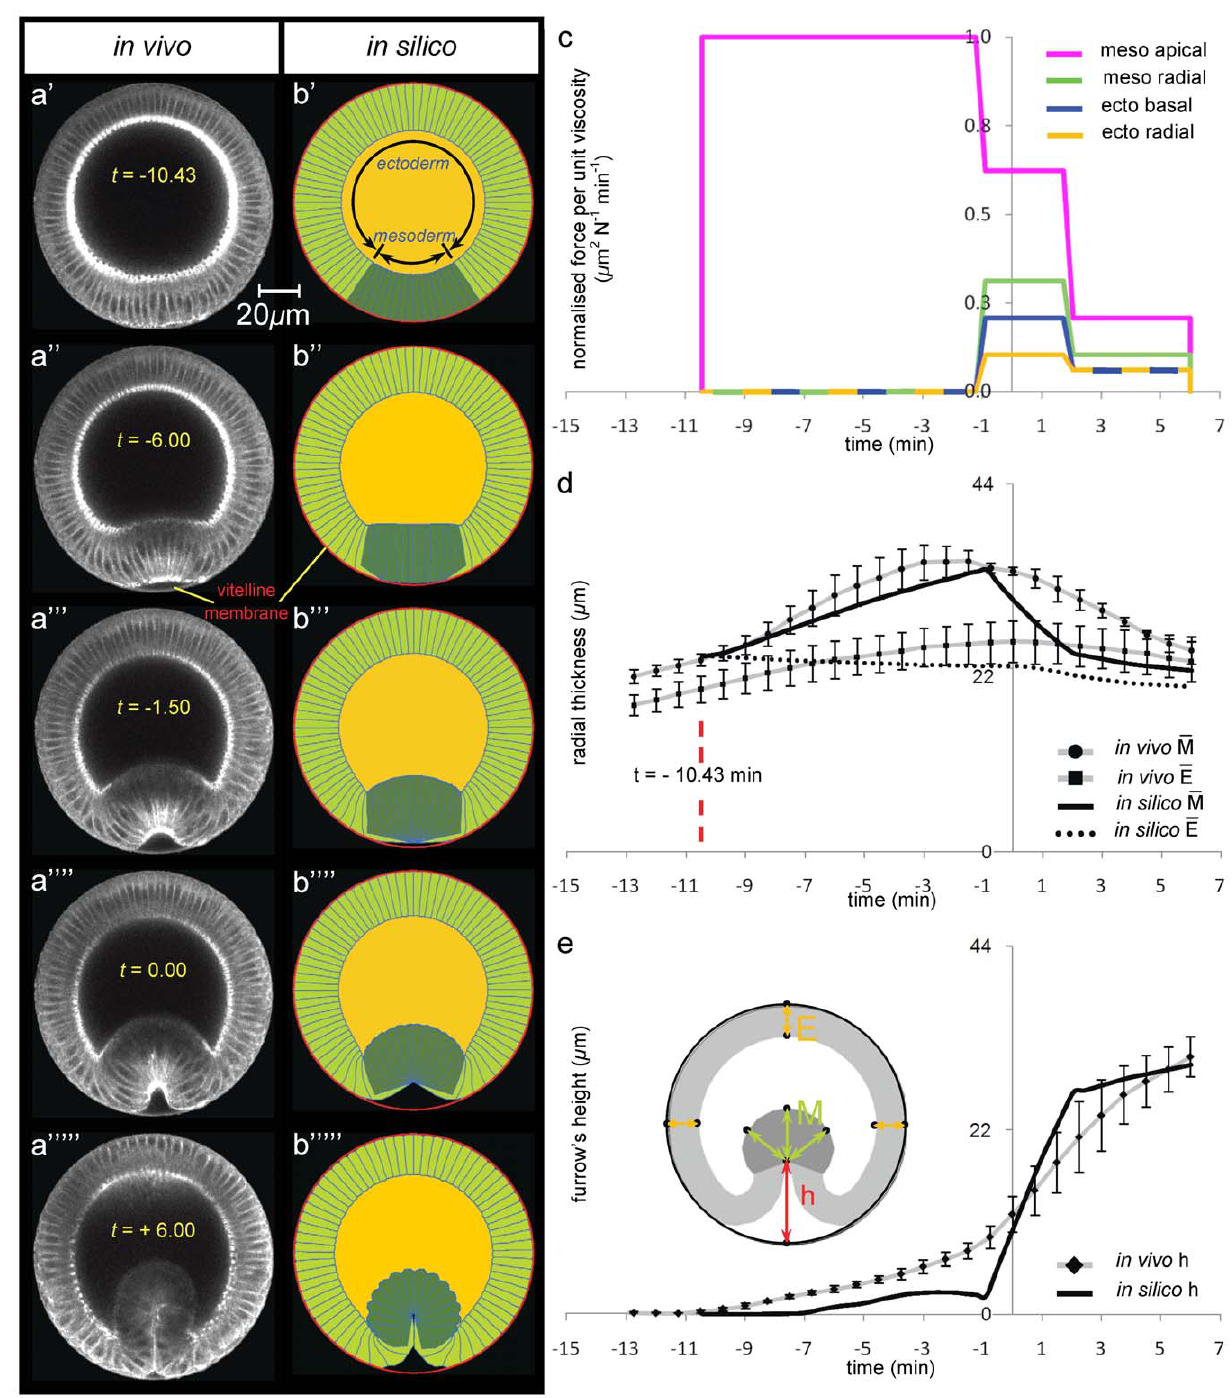
Figure 3. Modelling ventral furrow invagination: wild type genotype. ( a ) Selected multi-photon images (columns) of in vivo transverse cross-sections of a wild type embryo during ventral furrow formation. The embryo is labelled with Sqh-GFP and is oriented with its dorsal surface upward (Fig. 1a). The time interval between successive frames is 45 sec. Time zero was set by using apical-basal cell height profiles on the dorsal side (Fig. S2a). ( b ) Selected frames (columns) of in silico transverse cross-sections of a wild type genotype. The embryo’s 2D geometry is oriented with its dorsal side upward. Undeformed initial configuration (panel b 9 ) corresponds to in vivo deformations at t= 2 10.43 min (see panel d). ( c ) In silico force distributions utilised to simulate invagination in b). Total invagination interval [ 2 1.43, 6 min] has been subdivided in the three subintervals [ 2 10.43 min, 1.2 min], [1.2 min,2 min] and [2 min, 6 min] respectively referred to as the first , second and third invagination intervals . Force trends are a discretisation of the in vivo force distribution available in Brodland et al. [1]. Smooth variations in time and position of in vivo force distributions over epithelial regions have been discretised to in silico force distributions that vary with time but not with position over epithelial regions. It is worth noticing that the components constituting the in vivo mechanism of invagination (mesodermal apical constriction, ectodermal basal constriction, ectodermal and mesodermal radial shortening) have been preserved. ( d ) Time-trends of average radial mesodermal and ectodermal thicknesses of